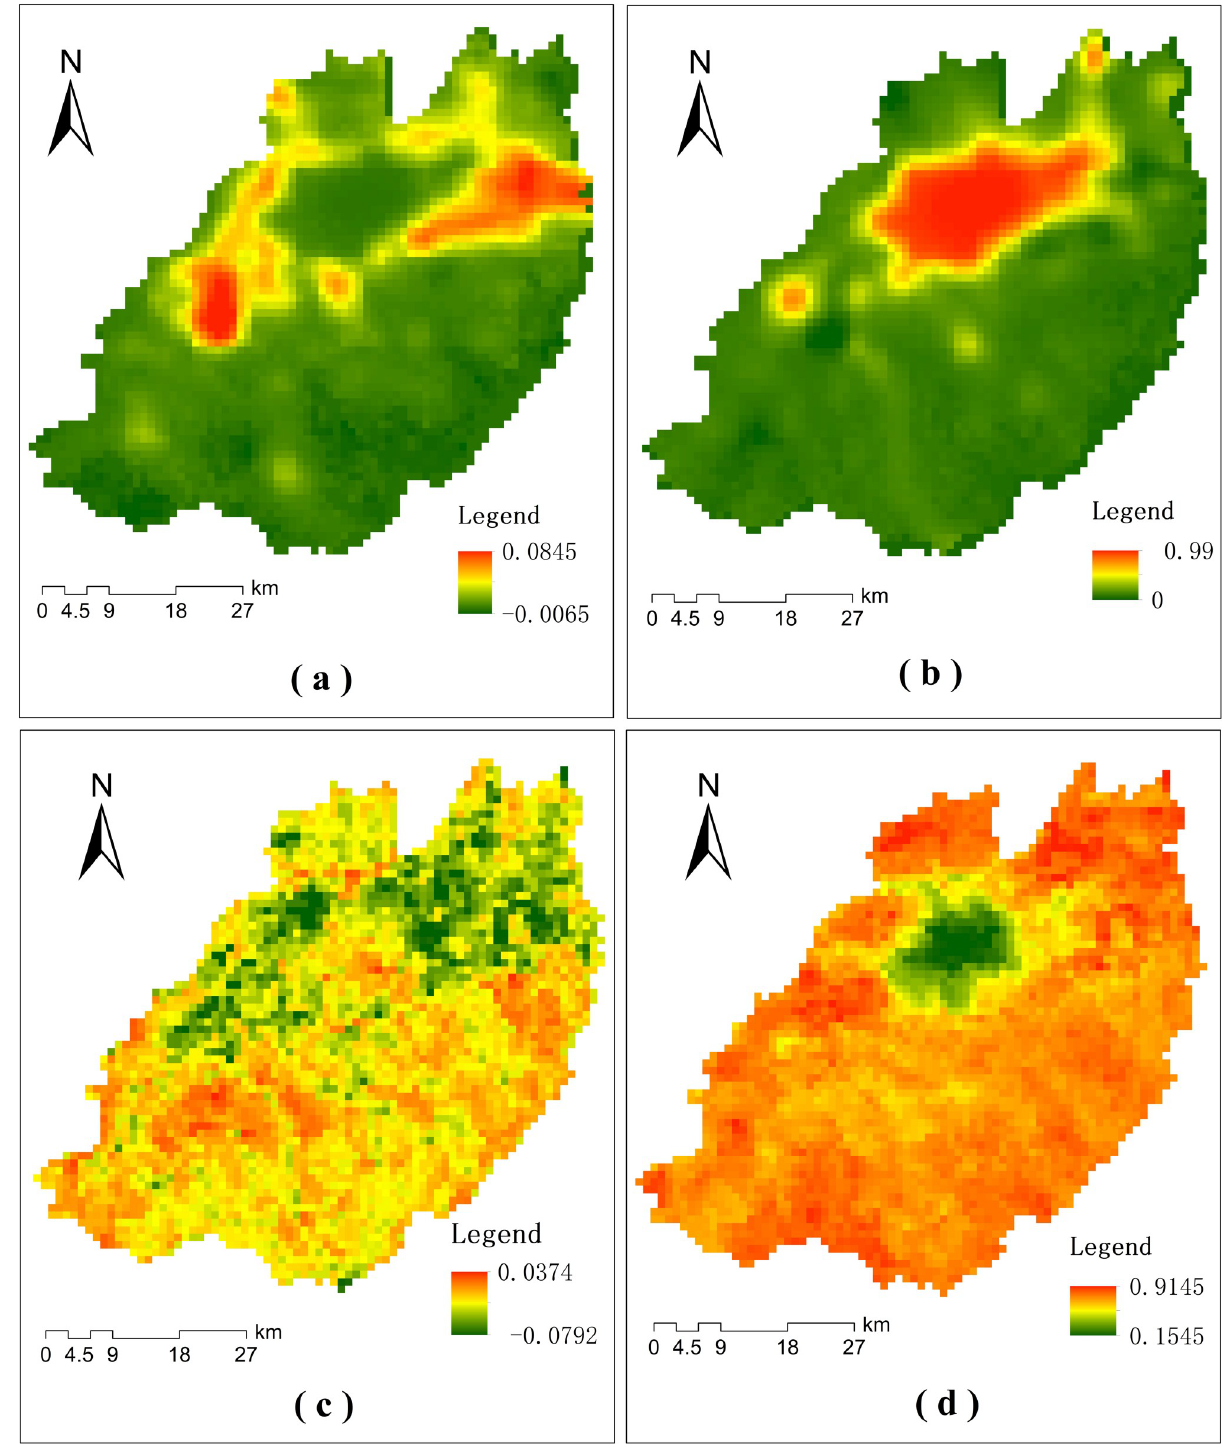
Fig 5. The spatial distributions of the linear model parameters. (a) map of a NTL values; (b) map of b NTL values; (c) map of a NDVI values; (d) map of b NDVI